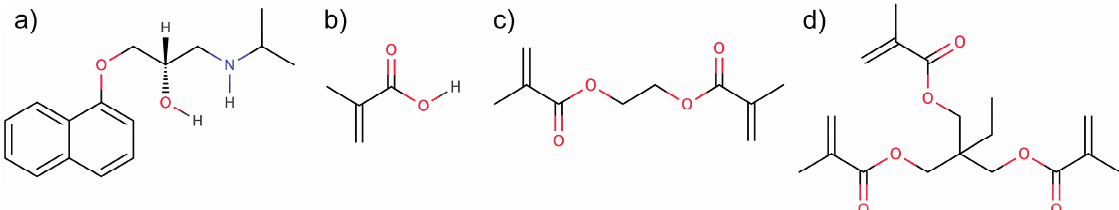
Figure 1. Structures of compounds used in this study: ( a ) the template ( S )-propranolol (SPR); ( b ) the functional monomer methacrylic acid (MAA); ( c ) the crosslinking monomer ethylene glycol dimethacrylate (EGDMA) and ( d ) the crosslinking monomer trimethylolproprane trimethacrylate